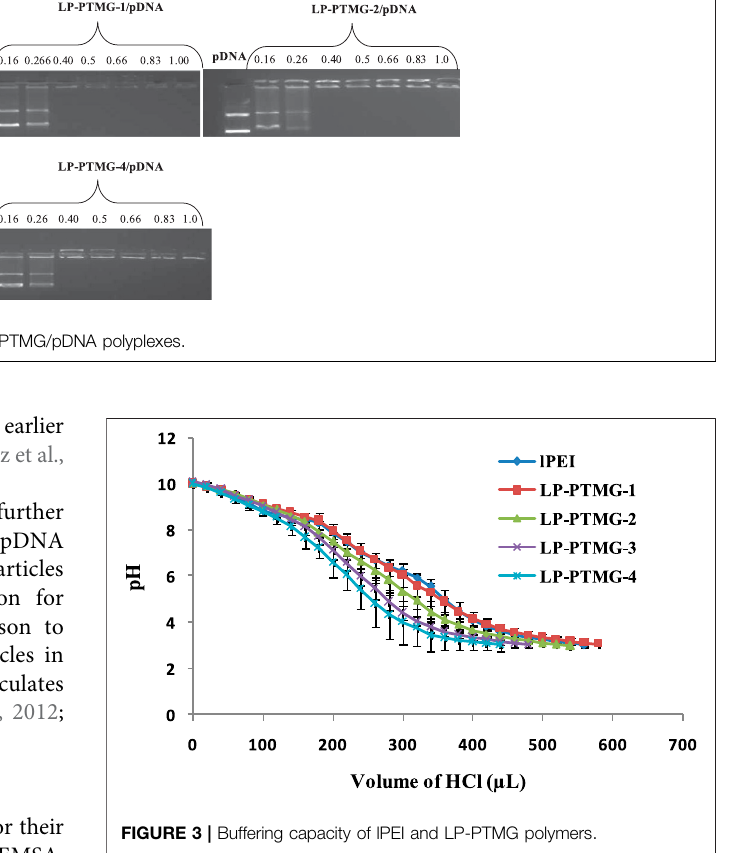
Frontiers in Nanotechnology |